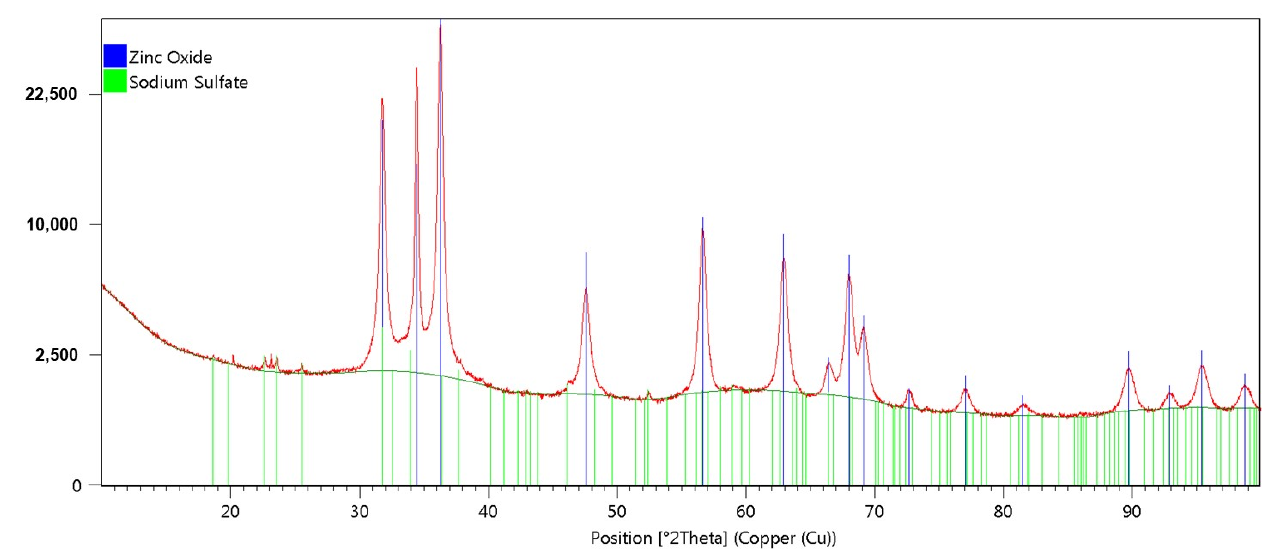
Figure 3. XRD pattern of the biosynthesized ZnO NPs.